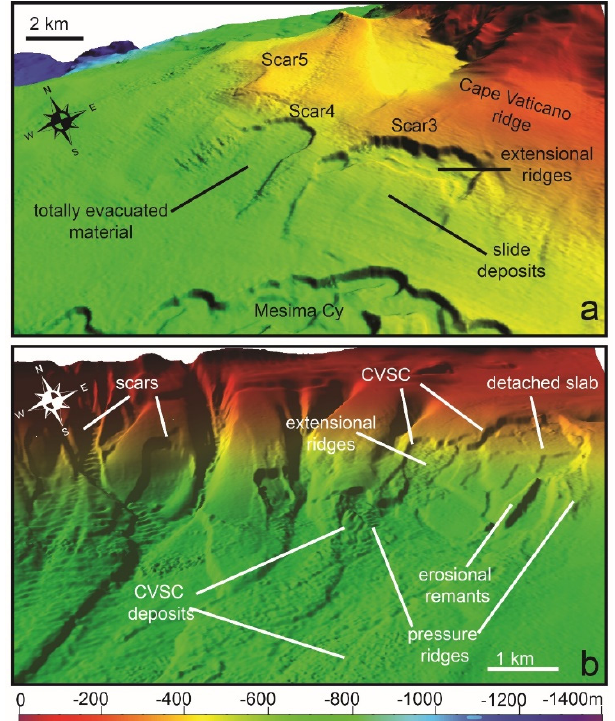
Figure 5. 3–D view of ( a ) the landslide scars affecting the open continental slope encompassed between Cape Vaticano ridge and Mesima Canyon and ( b ) the Capo Vaticano Scar Complex (CVSC) mostly affecting contourite deposits formed on the upper continental slope. For location see Figure 1.